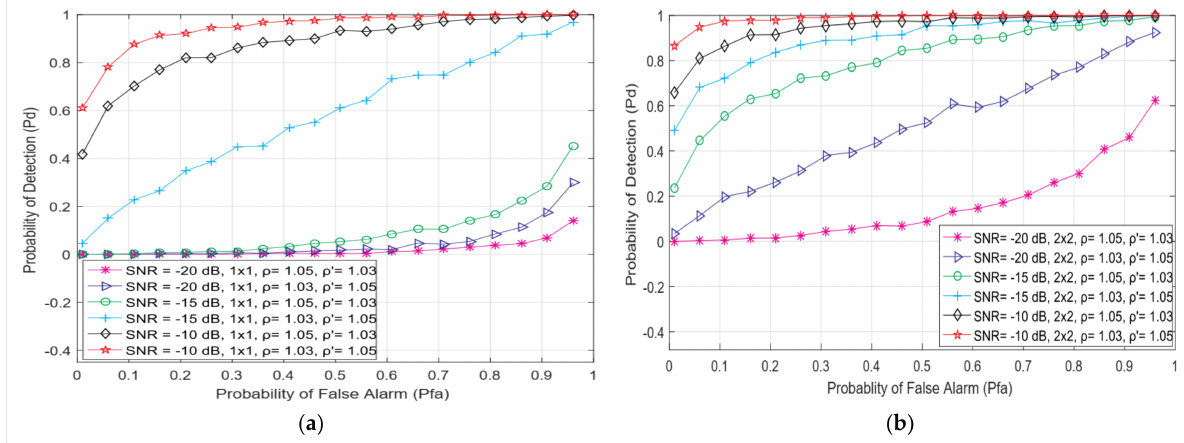
Figure 9. The ROC curves for various NU and DDT factor combinations and for different values of the SNRs ( − 20, − 15, and − 10 dB) in ( a ) SISO and ( b ) 2 × 2 MIMO systems for transmission characterized with QPSK modulation, N = 128 and P Tx = 100